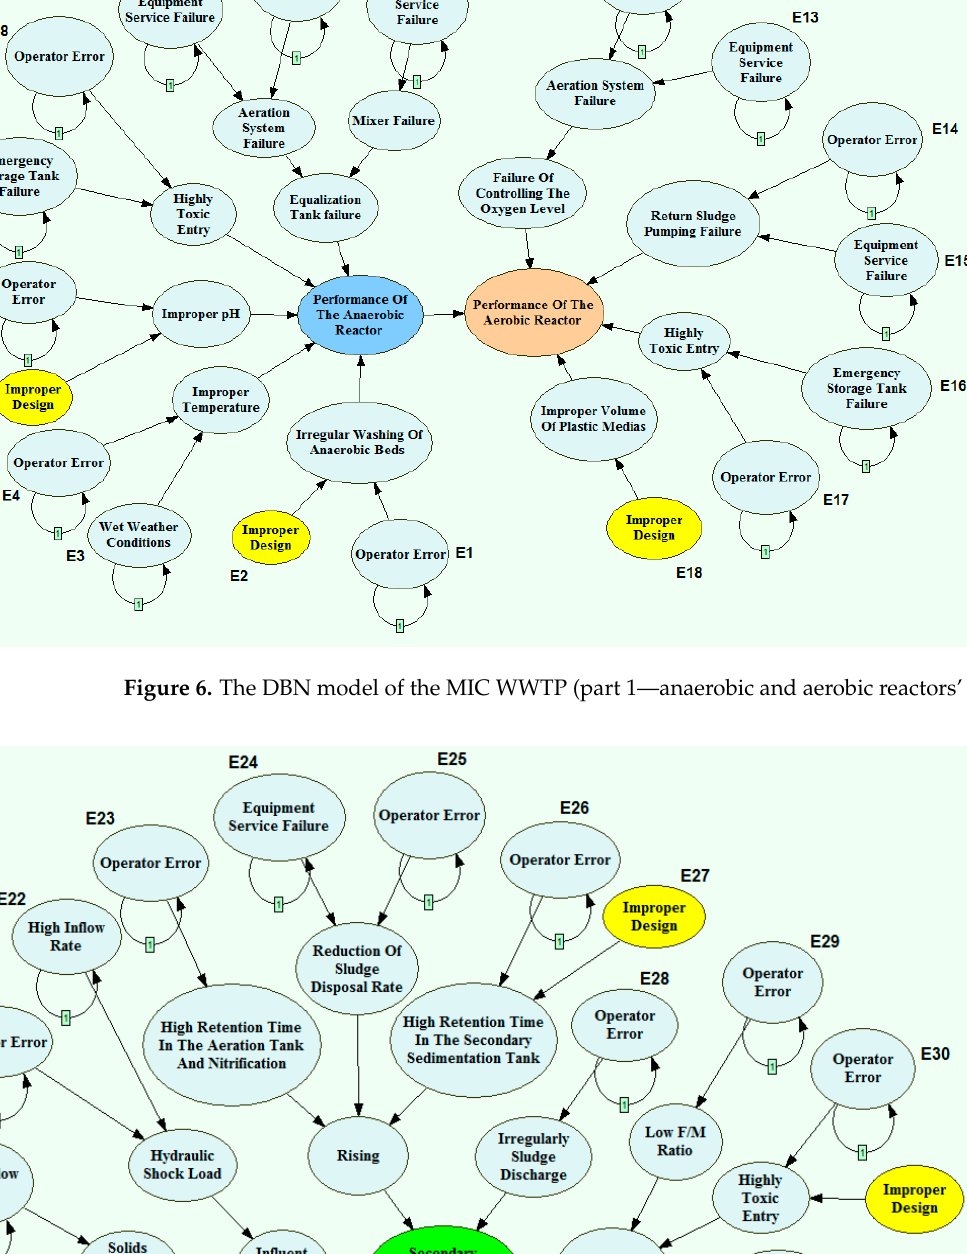
Figure 8. The DBN model of the MIC WWTP (part 3). In addition, three types of dependencies are available between nodes which are de- fined: (i) from dynamic node to dynamic node, (ii) from static node to static node and (iii) from static node to dynamic node [49]. In this study, all parent nodes except improper design are identified as the first-order dynamic nodes—the probability of the current time step depends on the previous time step. The intermediate and leaf nodes are considered static. However, these can give dynamic failure estimates, obtaining the time-variant probabilities from the root nodes. The network, which corresponds to anaerobic and aerobic reactors’ performance (Figure 6), has eight, three, four, two and one parent nodes for operator error, improper designs, equipment service failure, emergency reservoir tank failure and wet weather con- ditions, respectively. The improper design node highlighted in yellow is the static variable that does not change throughout the time steps. As shown in Figure 6, secondary sedi- mentation tank failure has been affected by the parent nodes consisting of seven operator error variables, three improper design nodes, one equipment service failure variable and two high inflow rate nodes. The normal arcs connect the intermediate nodes, while the self-rolling arcs connect a root node’s current probability to the past time-step.